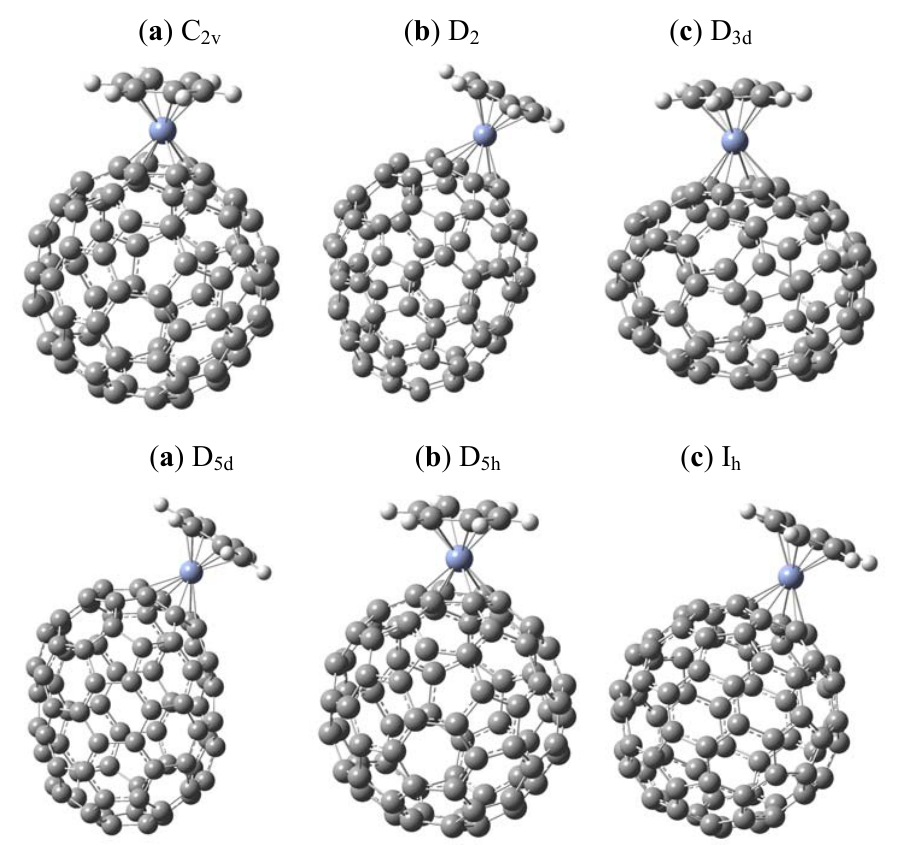
isomers under 80